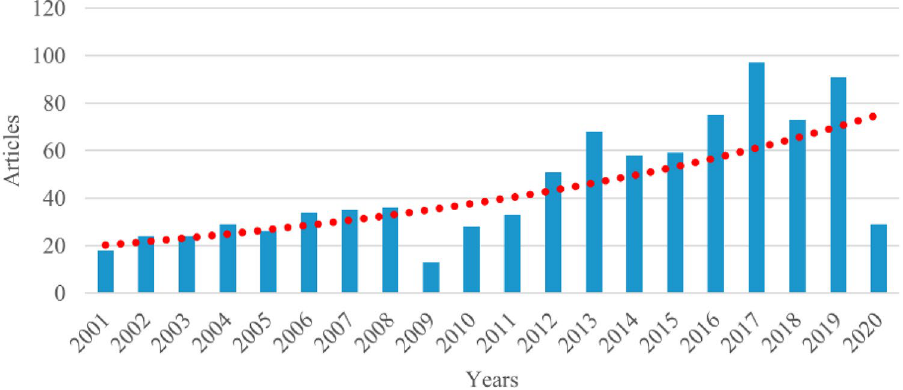
Figure 1. Underwater welding research (Data until the first quarter of 2020) 2 .